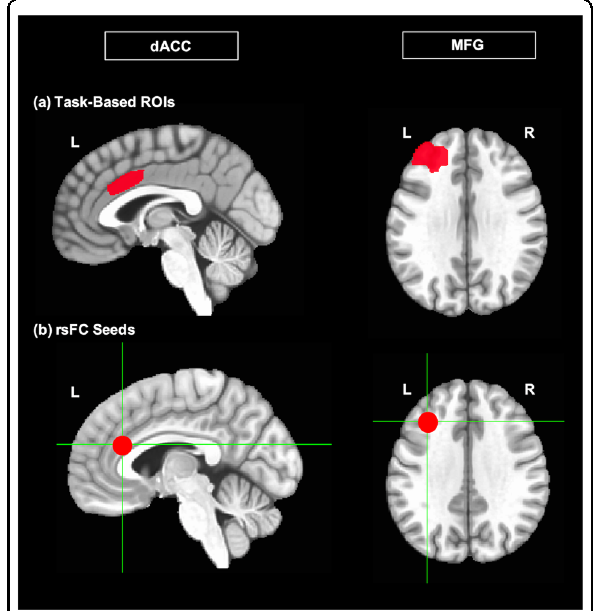
Fig. 1 A priori regions of interest (ROIs) in the cognitive control network (CCN) de fi ned for circuitry-based analysis: (left) middle frontal gyrus (MFG); (right) dorsal anterior cingulate cortex (dACC). a ROIs from which beta values were extracted for Stroop/ Flanker task-based analysis of target engagement. b Placement of 4 mm spherical seeds in the MFG and dACC for resting-state functional connectivity (rsFC) analysis of target engagement.